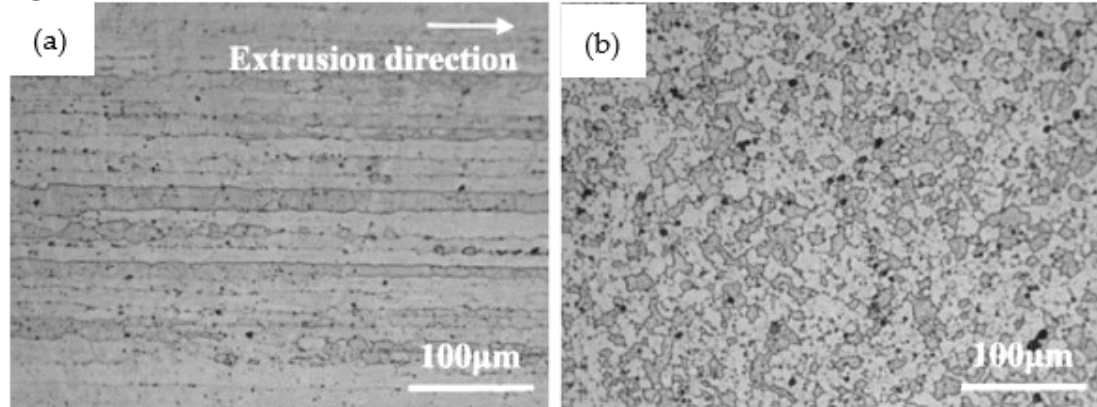
Figure 3. The optical microstructures of the extruded Al-Zn-Mg-Cu-based alloy: ( a ) along the extrusion direction and ( b ) perpendicular to the extrusion direction.